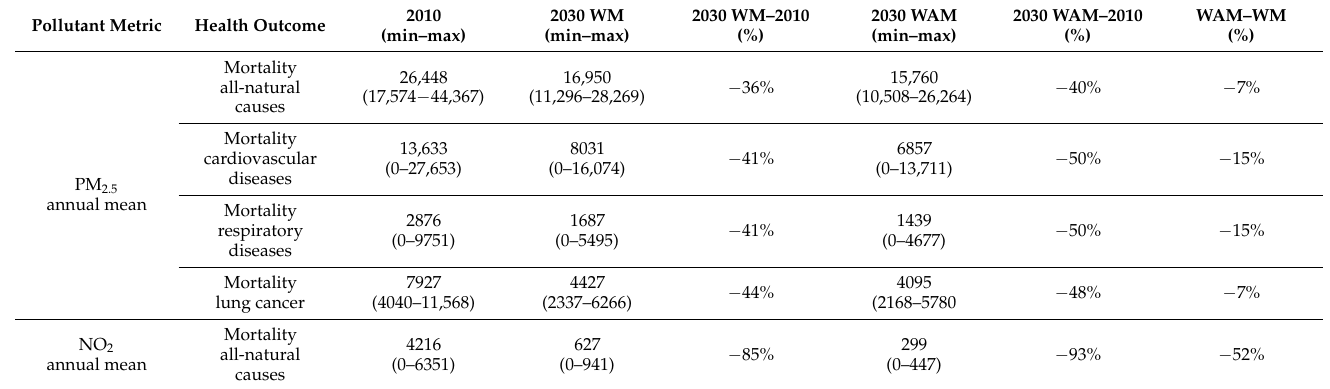
Table 9. Sensitivity of mortality results to alternative RR.